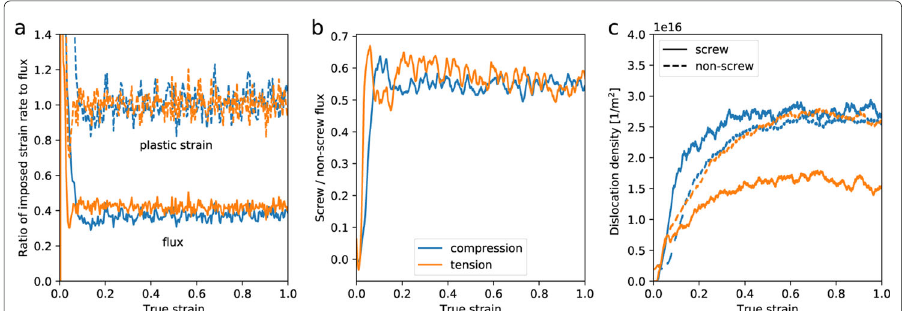
Fig. 6 In all panels curves pertaining to tension are shown in orange and curves pertaining to compression are shown in blue. a Ratio of the imposed straining rate to the total dislocation flux ˙ ε/ ˙ γ (solid lines) and ratio of the rate of plastic strain accumulation to the imposed straining rate ˙ ε/ ˙ ε p zz (dashed lines). b Ratio of the flux due to screw dislocations to the flux due to non-screw dislocations. ( c ) Densities of screw (solid lines) and non-screw (dashed lines) dislocations as functions of